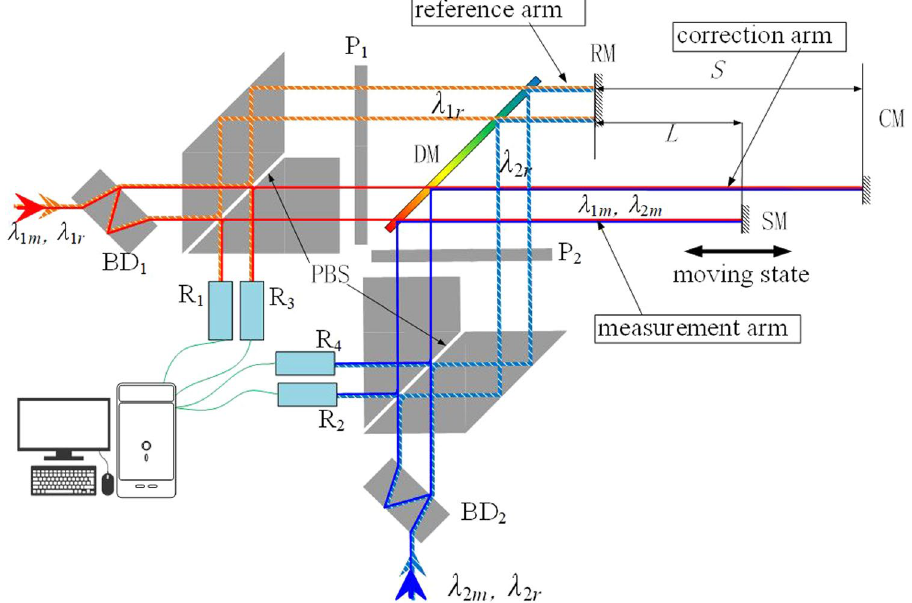
Figure 1. Schematic illustration of the two-color heterodyne laser interferometer with the uncertainty correction of the optical distances. BD 1-2 : beam divider, PBS: polarizing beam-splitter, P 1-2 : quarter-wave